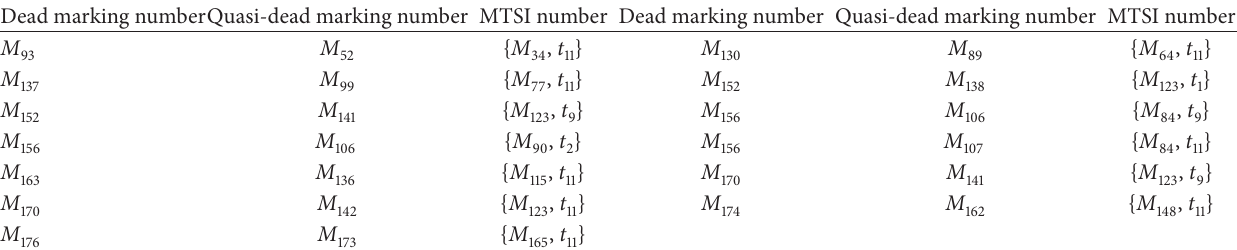
Table 6: The information of type II CMTSIs.